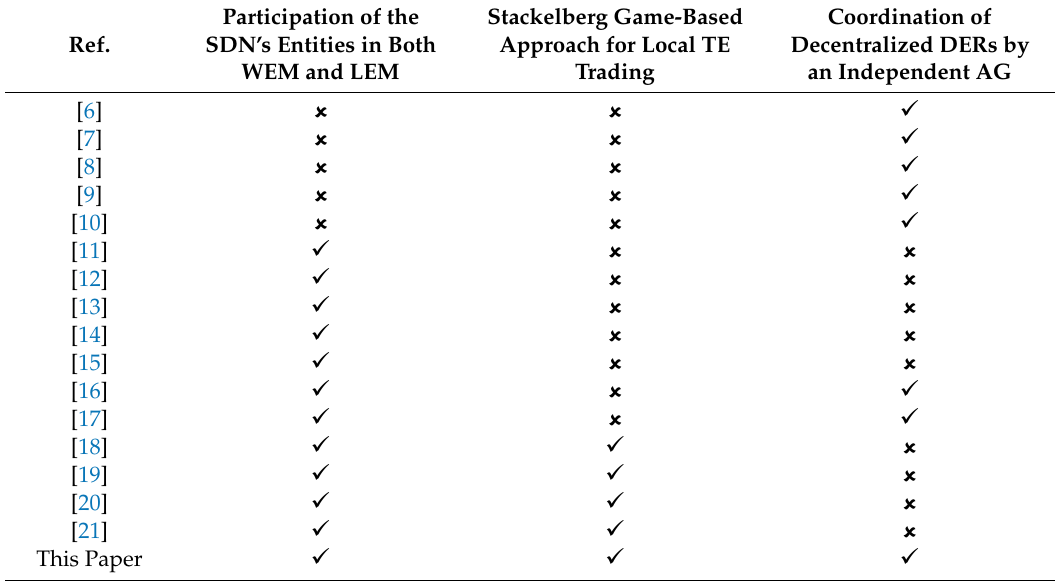
Table 1. A comparison between the current study and previous research works. Ref.